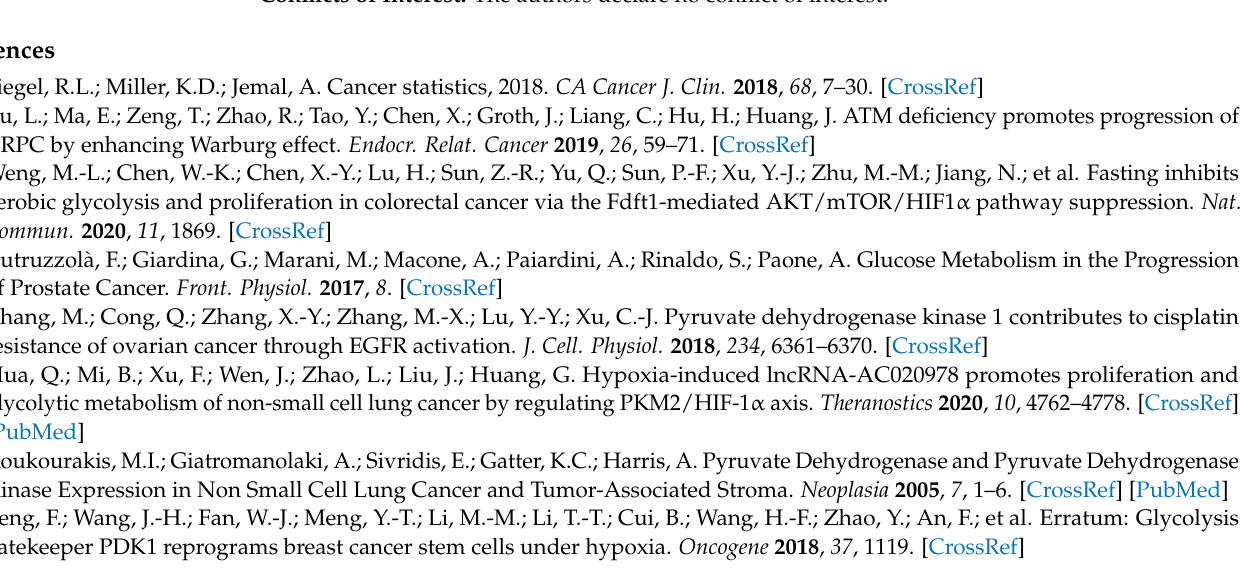
Table S1: Genotyping for rs1530865 and rs2357637 in prostate and ovarian cell